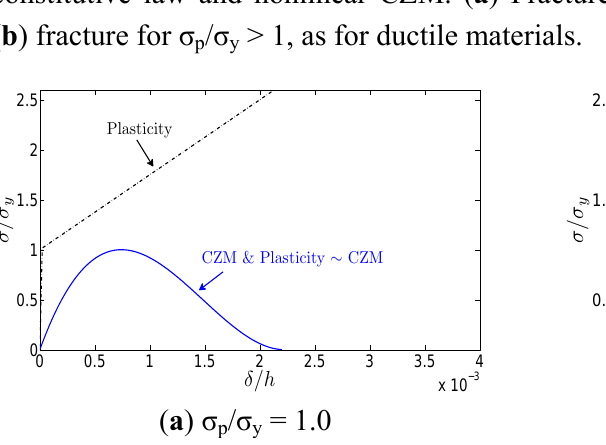
/ σ ≤ 1, as for brittle materials; p y